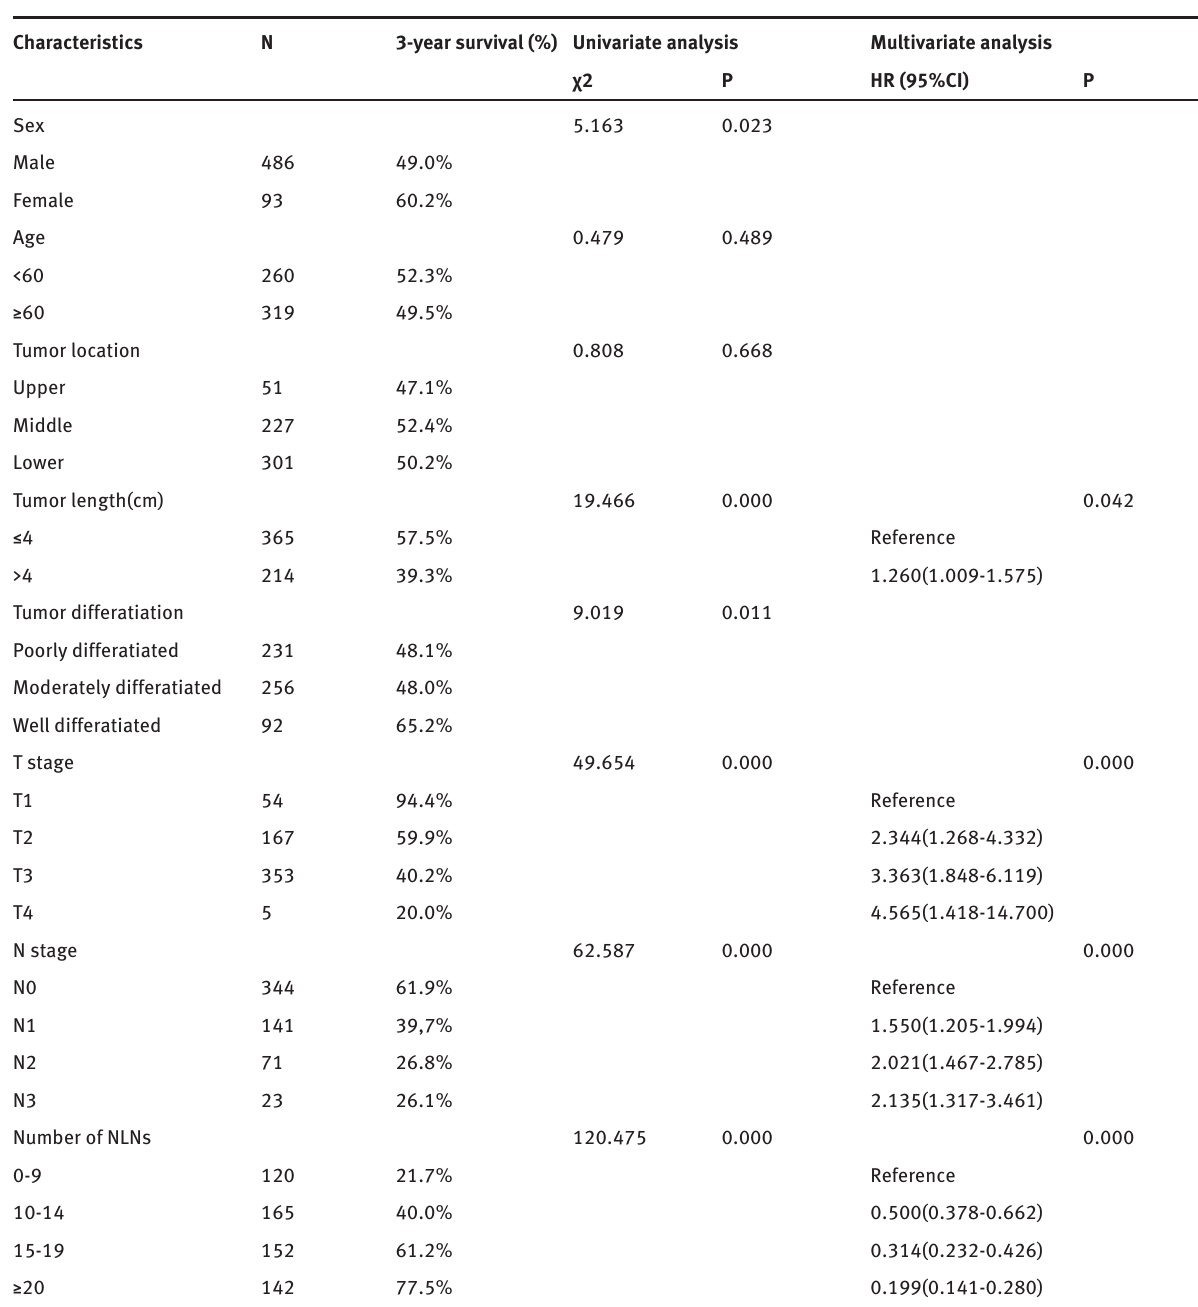
Table 2: Univariate and multivariate analysis of prognostic factors for overall survival.